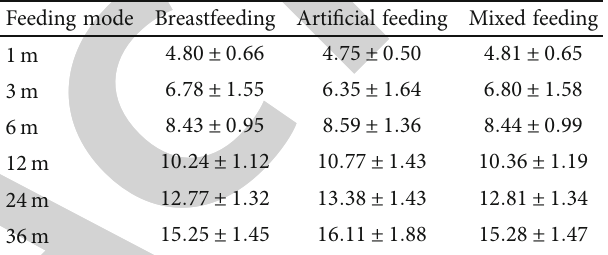
Table 2: E ff ects of feeding methods in di ff erent periods on body weight development ( (cid:1) x ± s,